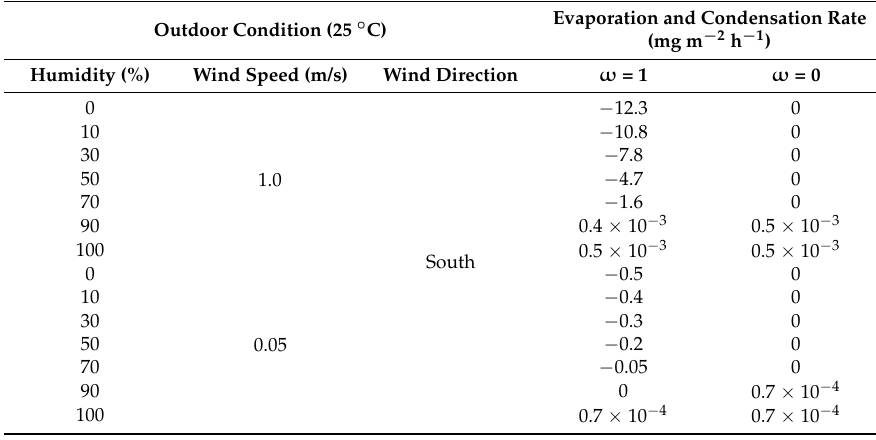
Table 5. Water thickness on the surface of the concrete relevant to the outdoor